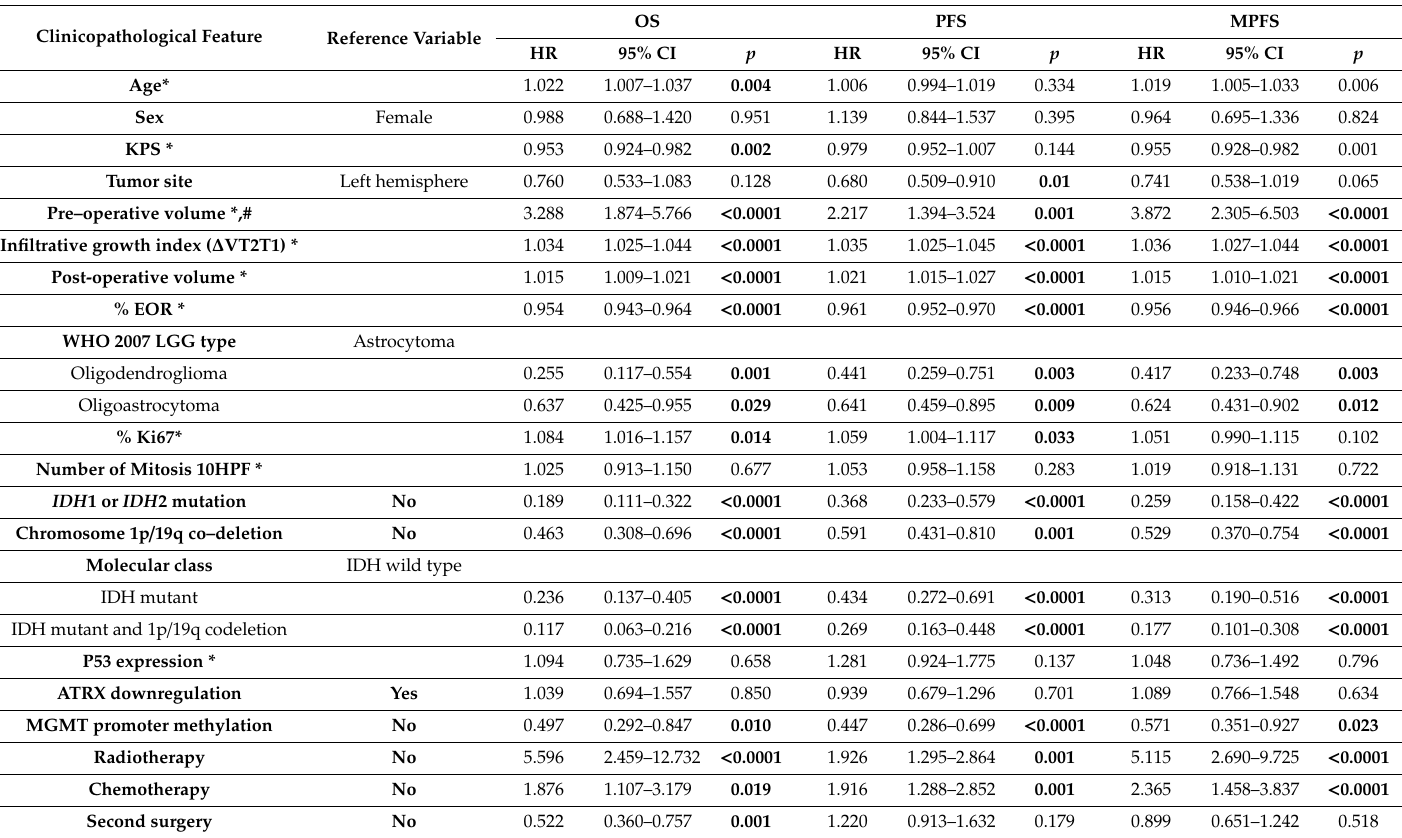
Table 3. Univariate analysis of clinical, histological and molecular parameters in relation to overall survival (OS), progression-free survival (PFS), and malignant progression-free survival (MPFS) in 241 patients with